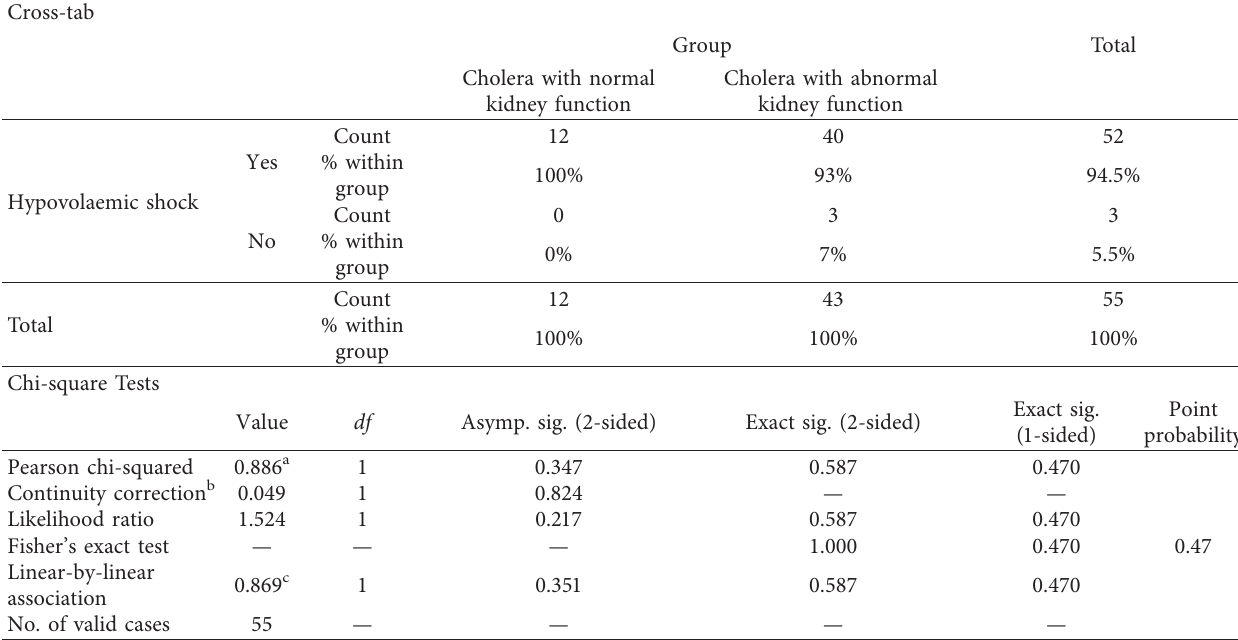
Table 2: Correlation of the hypovolaemic shock with cholera.